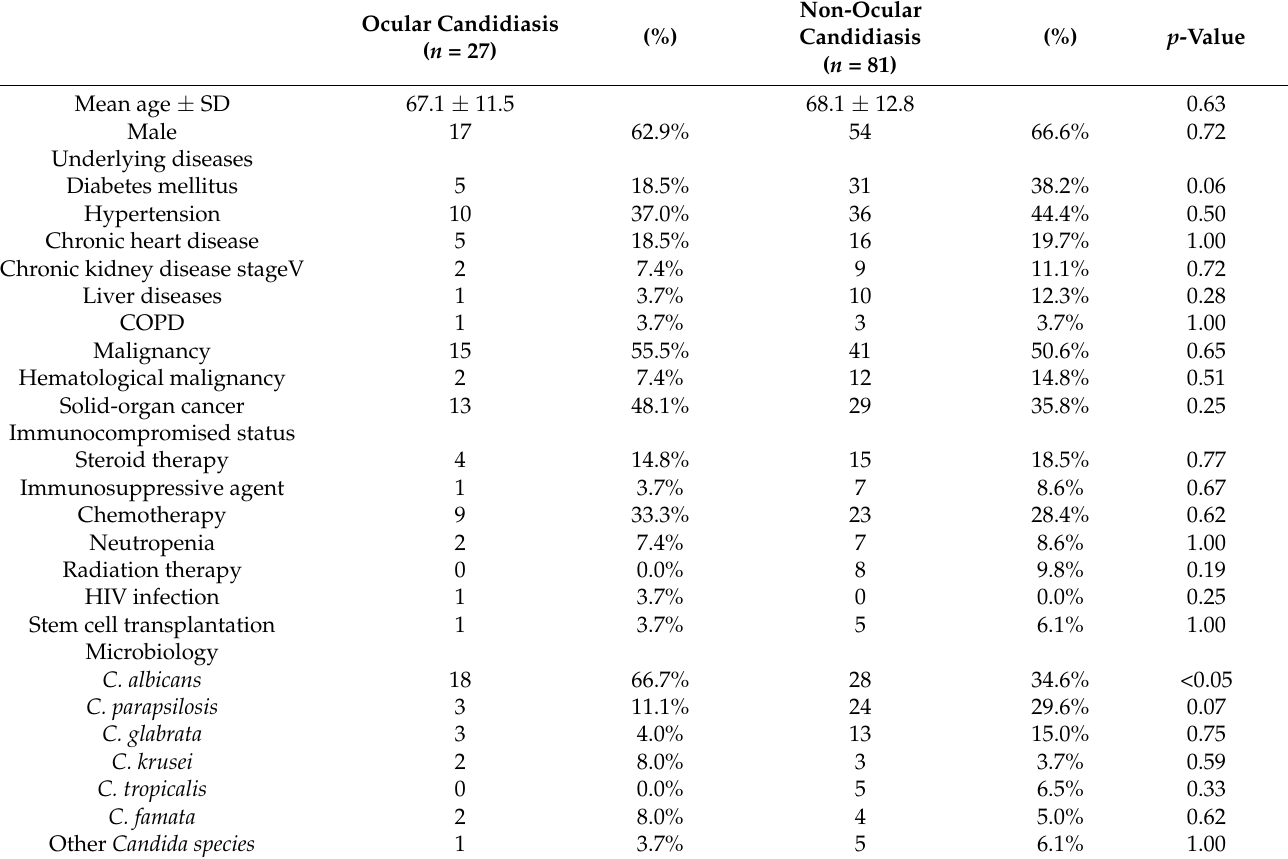
Table 2. Univariate analysis for the factors with ocular candidiasis in cases with candidemia. Ocular